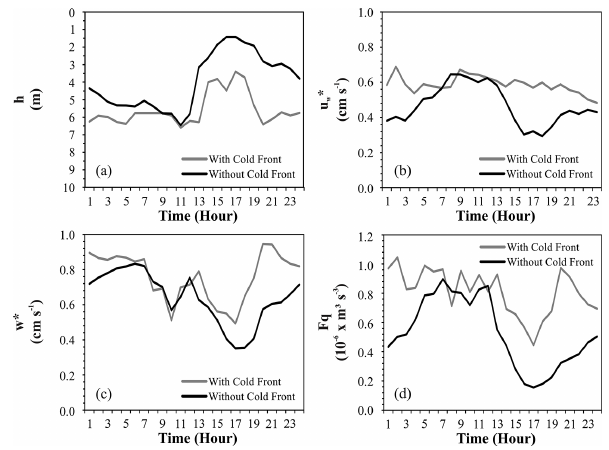
Figure 11. Impacts of a cold front on the DML dynamics: (a) DML depth, (b) water shear velocity scale, (c) penetrative entrainment velocity scale and (d) energy flux into the